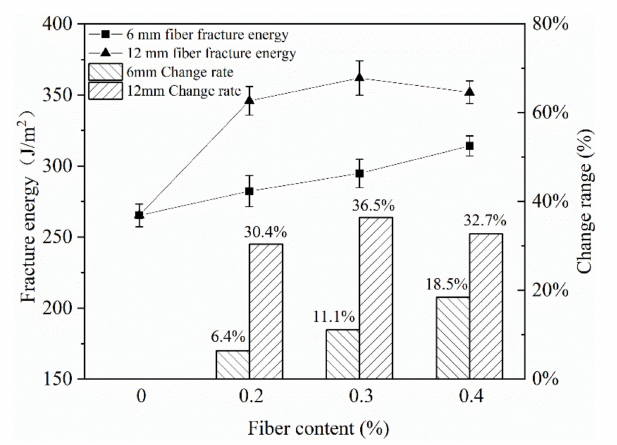
Figure 7. The influence of fiber on fracture